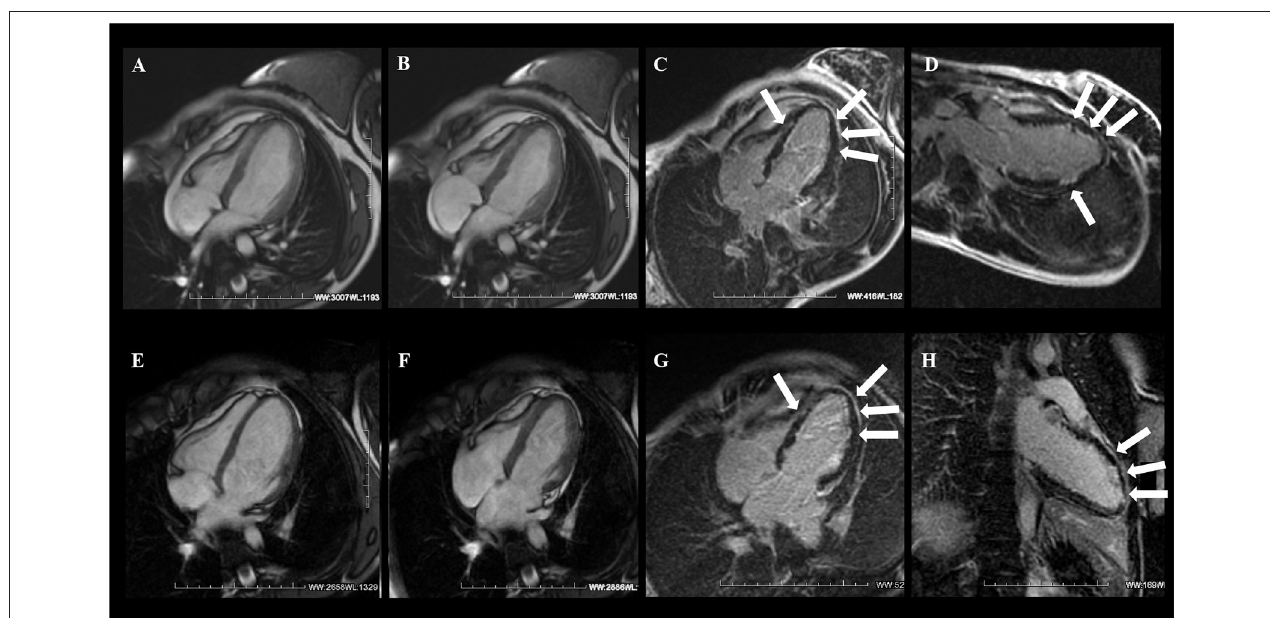
FIGURE 3 | A 21-year-old woman with sudden onset of dyspnea 1 week after delivery and without prior medical history. CMR examination with cine balanced steady-state free precession (bSSFP) sequence four-chamber view [end-dyastole (A) and end-systole (B) ] showed severely reduced LV systolic function without RV involvement. (C,D) T1-weighted inversion recovery gradient echo (T1w-IR-GRE) sequence acquired 10min after gadolinium administration showed diffuse subendocardial late gadolinium enhancement (LGE) of the LV (arrows). At 6 months’ follow-up, there was evidence of LV functional recovery (E,F) with diffuse LGE persistence (G,H) . Courtesy of Dr. Giovanni Donato Aquaro, Fondazione Toscana Gabriele Monasterio, Pisa,